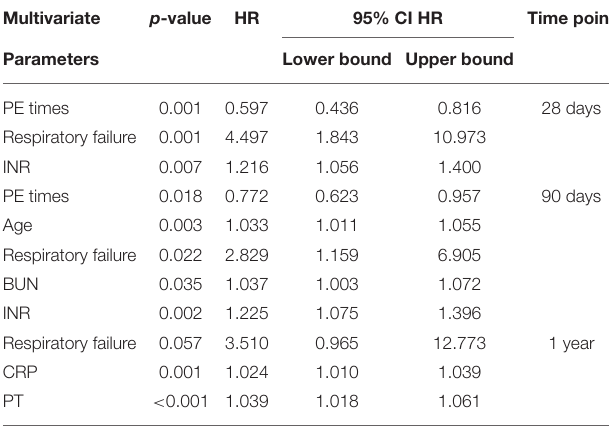
TABLE 5 | Prognostic factors in HBV-ACLF patients treated with PE-based